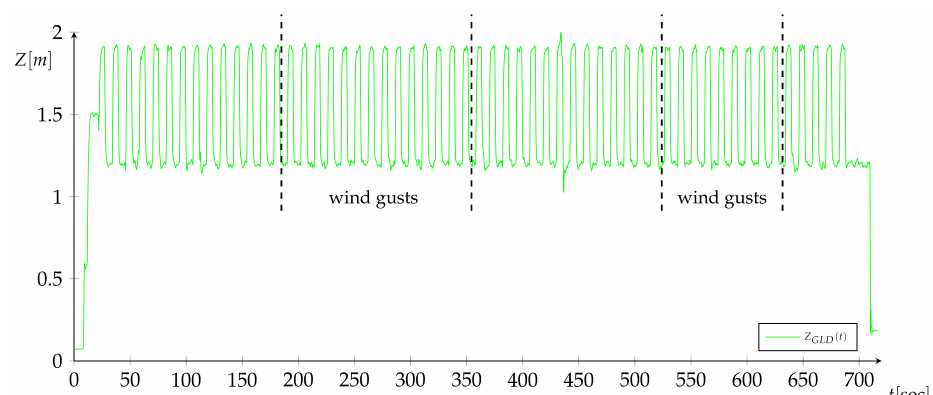
Figure 15. Time course for the GLD tuning process in the presence of wind